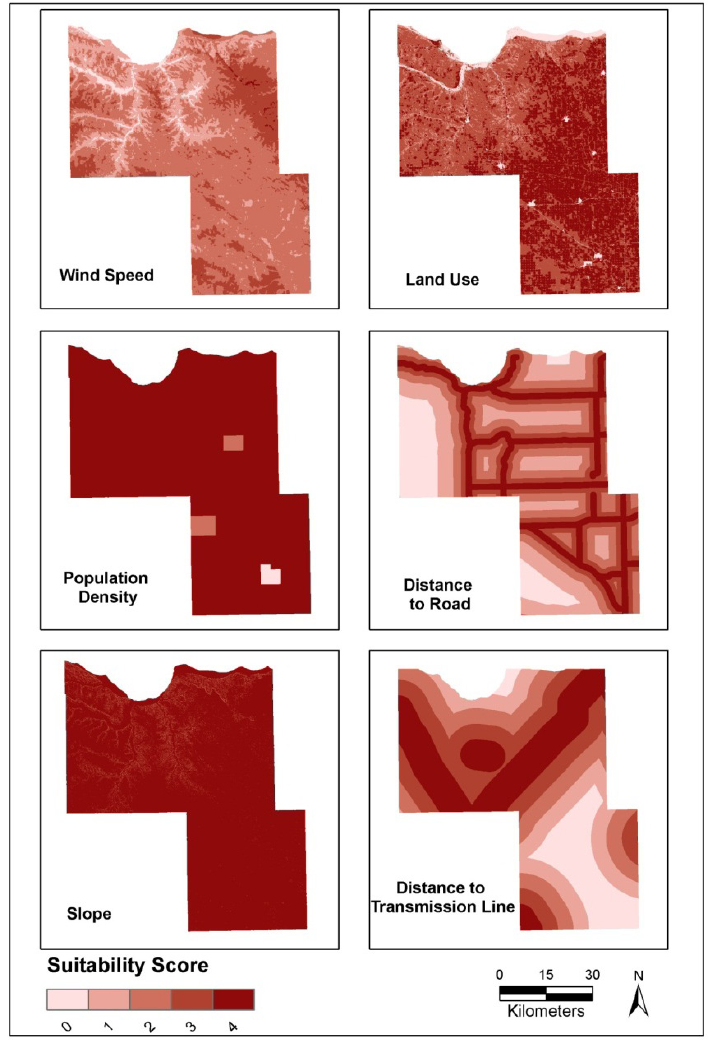
Figure 3. Spatial patterns of suitability scores for each criterion (exclusionary area